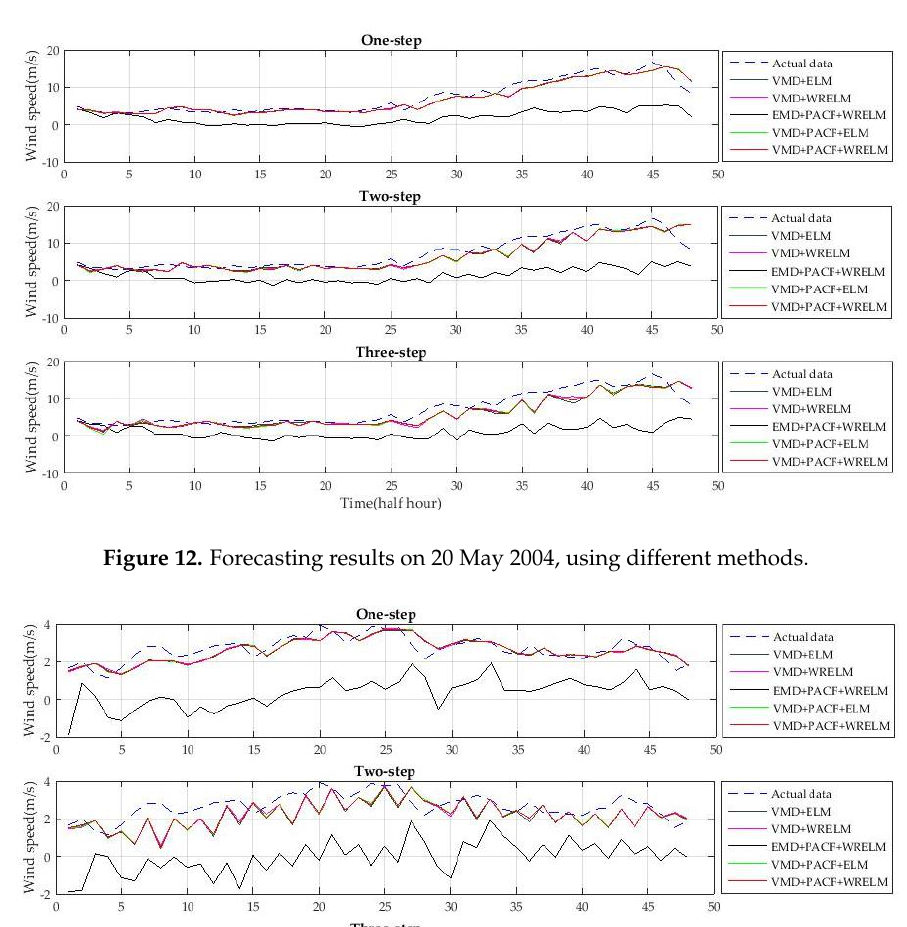
Figure 14. Forecasting results on 20 November 2004, using different methods. Table 5. Mean forecasting error of different methods. Methods MAPE (%)